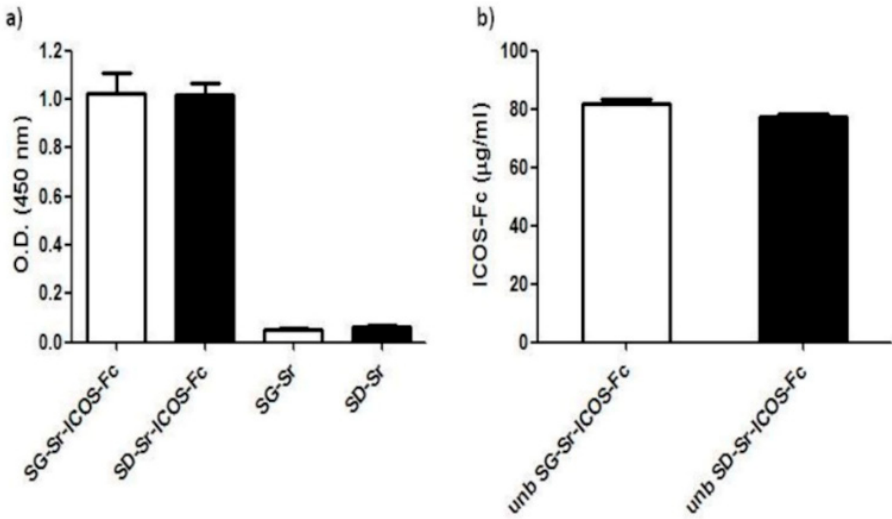
Figure 9. ELISA-like assay on ( a ) SG-Sr-ICOS-Fc, SD-Sr-ICOS-Fc, SG-Sr, SD-Sr, and ( b ) unb ICOS-Fc after grafting reaction. The binding and the amount of ICOS-Fc were detected by ELISA-like assay using the human ICOSL-His as the capture protein and anti-human-Hrp as detection antibody. Data are reported as Optical Density (OD) values and as concentrations expressed in µg/mL (mean and standard error were obtained from three independent samples evaluated in duplicate).